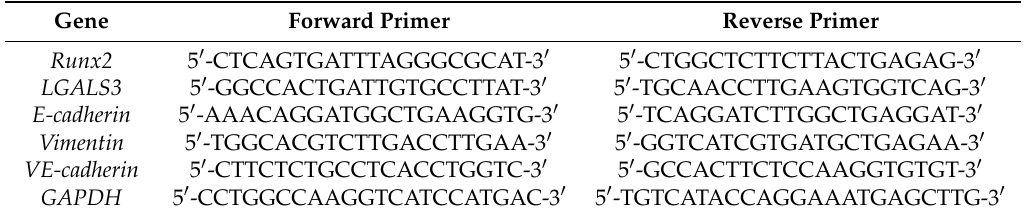
Table 3. RT-PCR primer